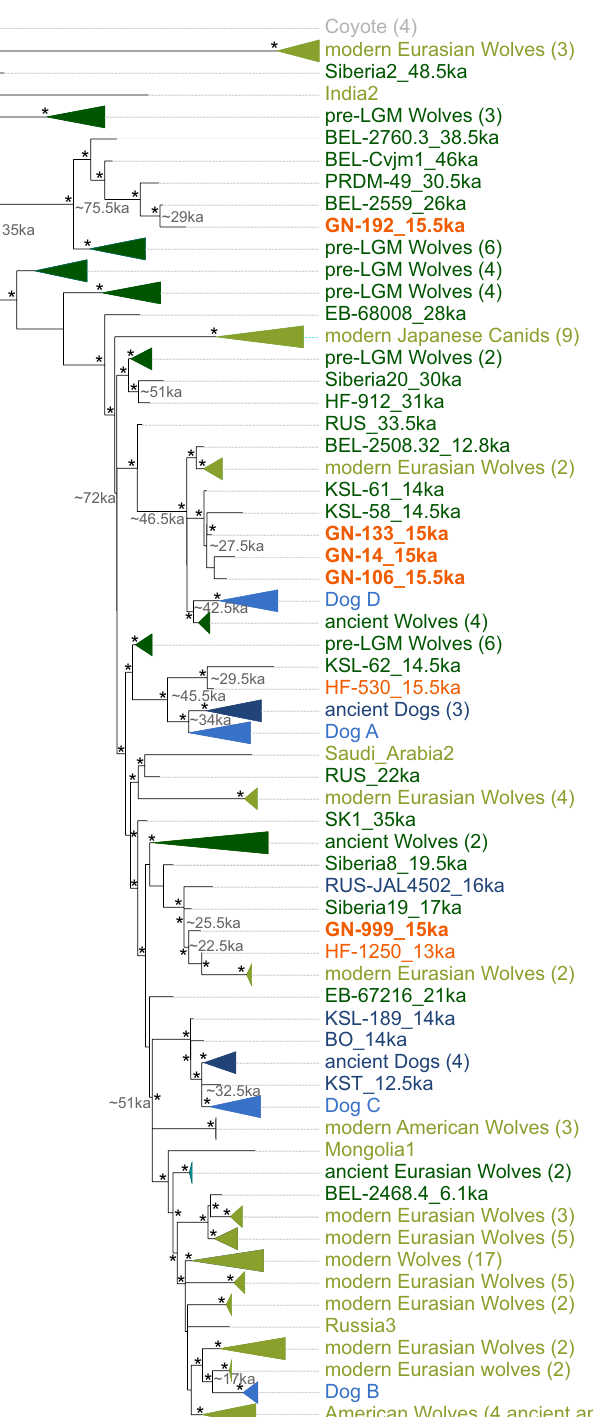
Figure 4. Maximum likelihood (ML) consensus tree of mitochondrial canid genomes. Newly generated samples are highlighted in orange; with the GN canids further bolded. Statistical support was assessed by generating 10,000 bootstrap replicates and nodes with bootstrap support higher than 95% are shown with an asterisk. Important nodes are labeled with respective node ages (given in ka cal BP) estimated using time-aware Bayesian phylogenetic inference (Figure S7). Ancient dogs are labeled in dark blue, modern dogs in light blue. Ancient wolves in dark green, modern wolves in light green. The ages of samples older 1,000 years are given in ka (cal